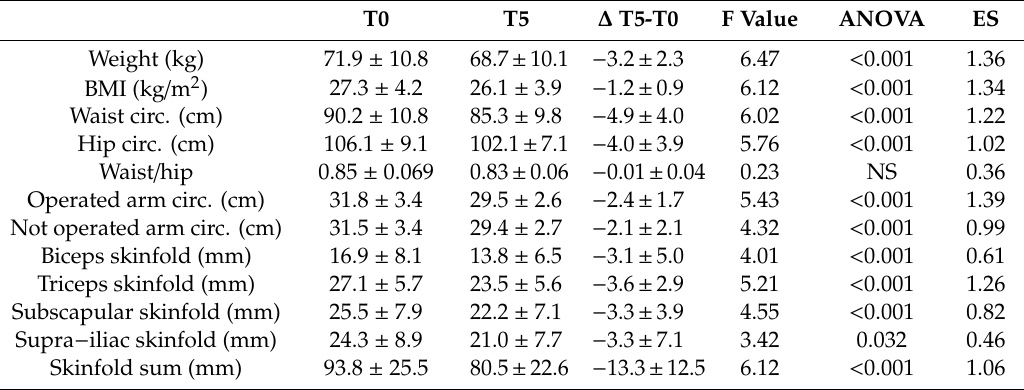
Table 1. Anthropometrics and skinfold parameters during 6 months